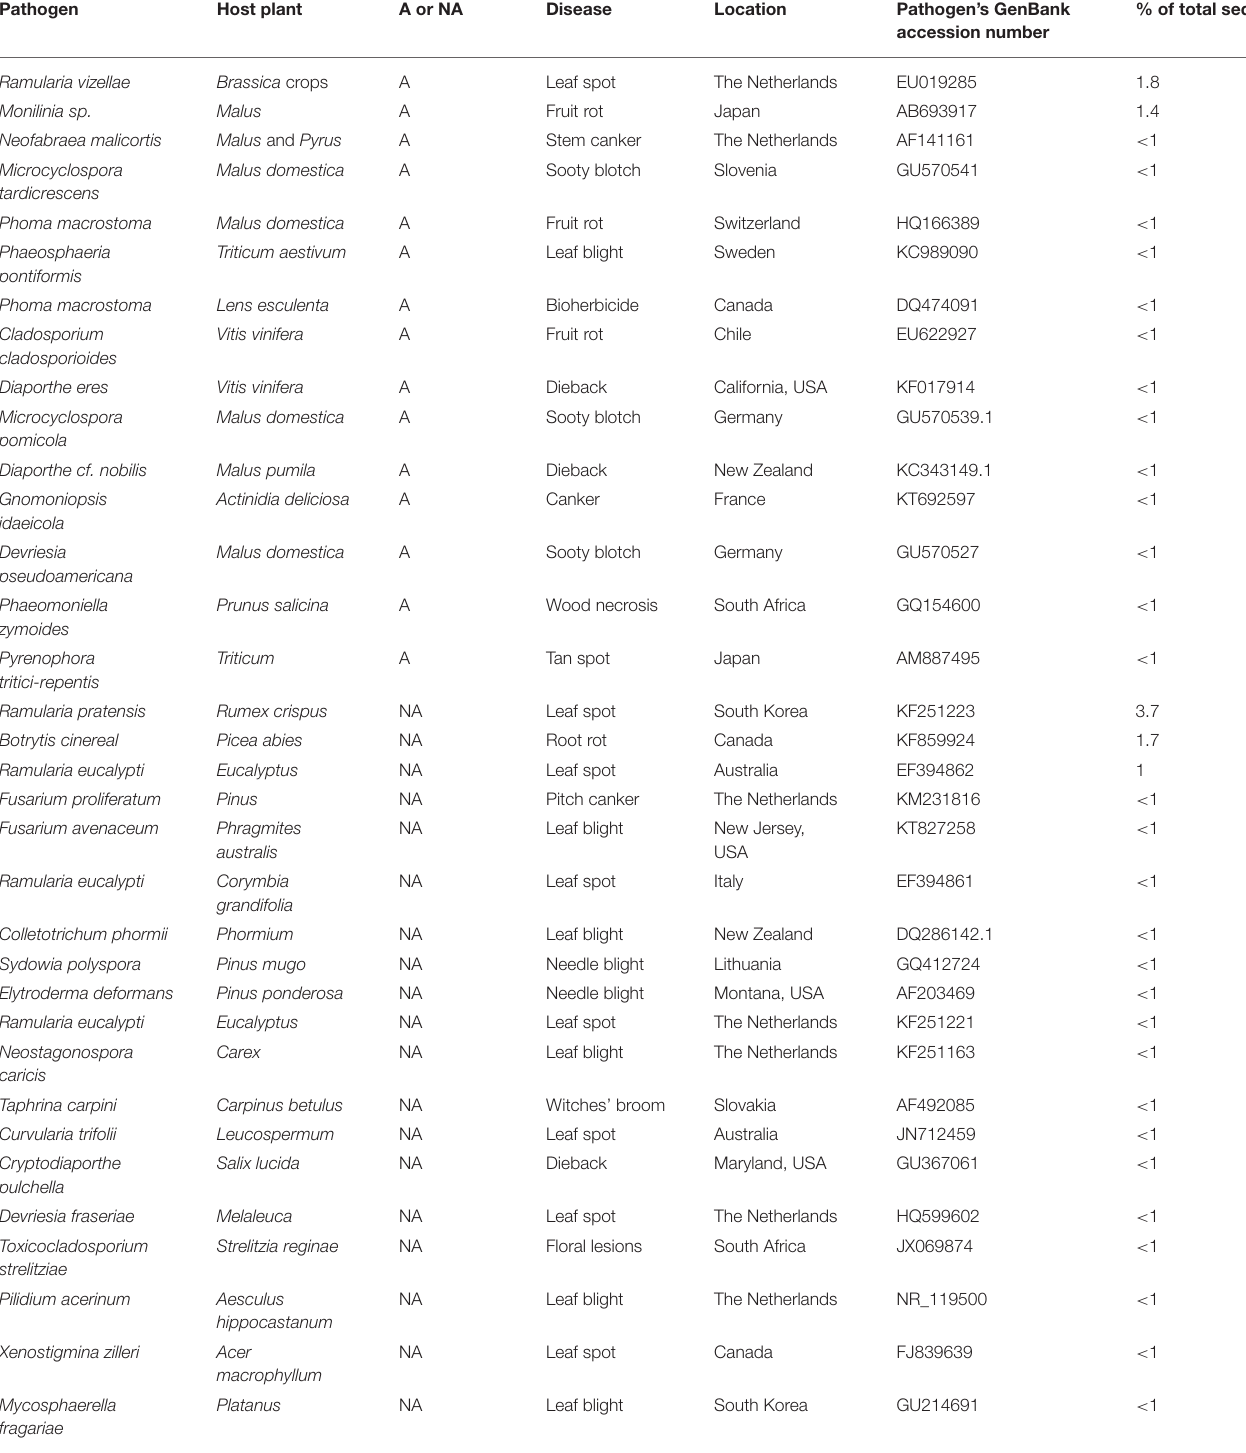
TABLE 1 | High-throughput sequencing of leaves of Populus trichocarpa indicated GenBank- and USDA SMML-reported pathogens of agricultural (A) or non-agricultural plants (NA), their diseases, locations, accession numbers, and % of total sequences in the